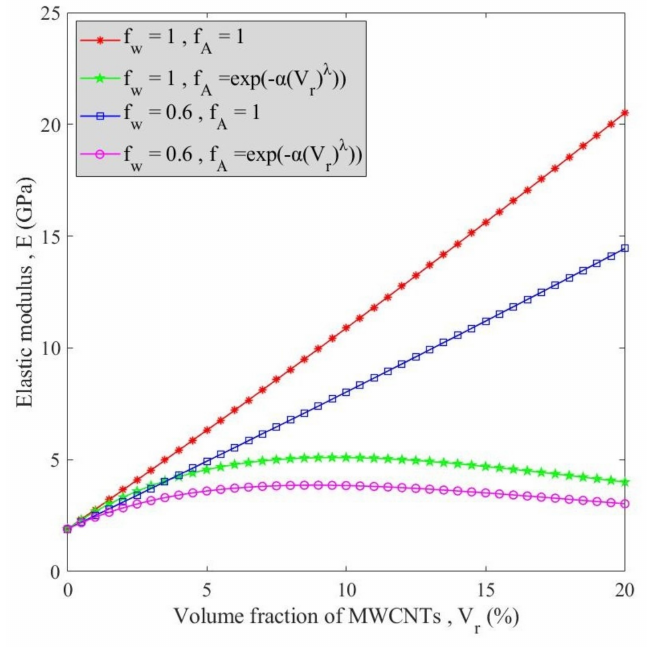
Figure 3. The influence of waviness and agglomeration factors on variation of elastic modulus of MWCNT-reinforced nanocomposite versus MWCNTs’ volume